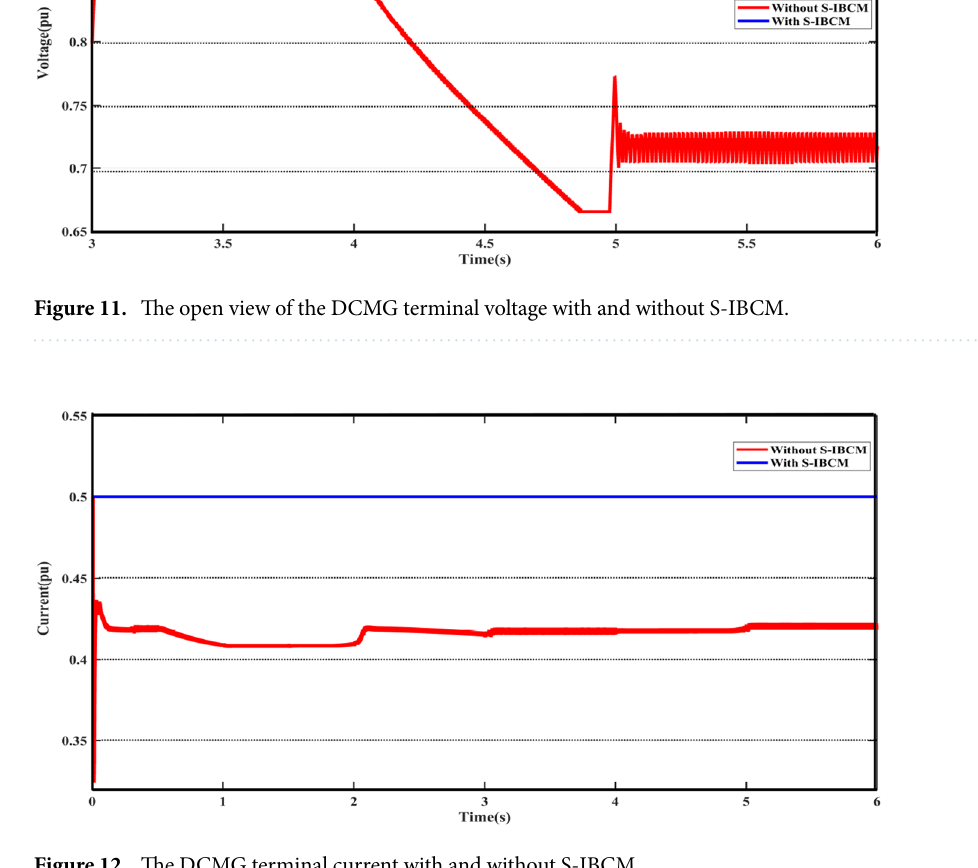
Figure 12. The DCMG terminal current with and without